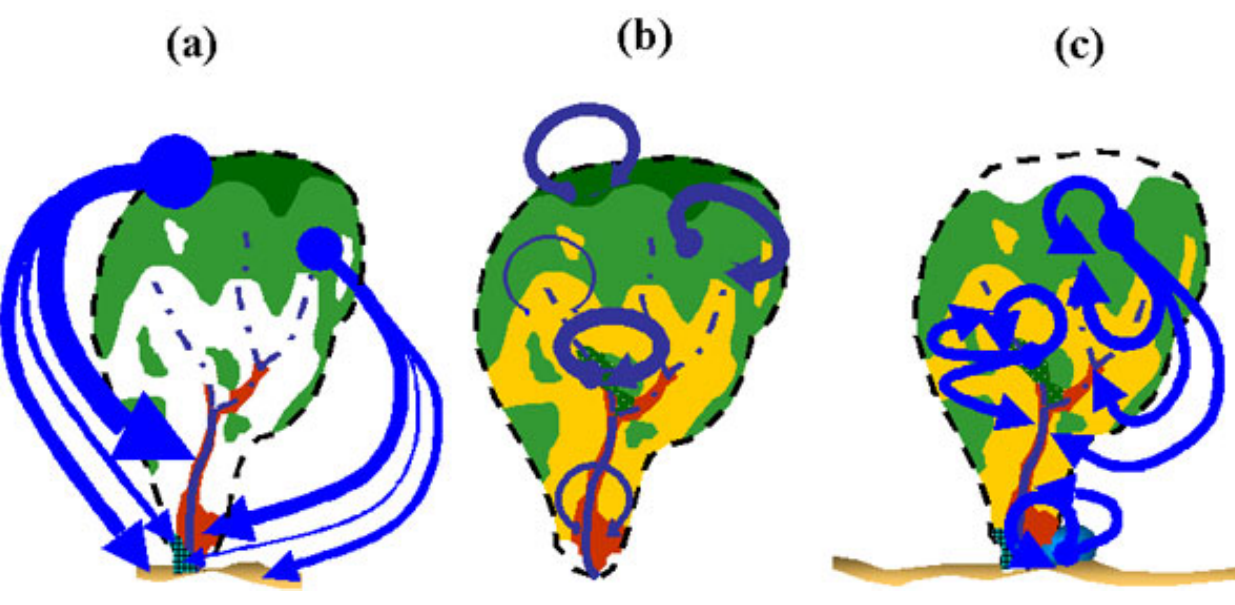
Fig. 5 . Spatial patterns of provision (dots) and delivery/use (head of arrows) of selected ecosystem services delivered in a tropical dry forest region in western Mexico: (a) freshwater provisioning service, (b) fertility maintenance regulating service, (c) bio-regulation services. Socioecological units relevant to the services match with those in Fig. 3. Thinner lines indicate services for which provisioning is